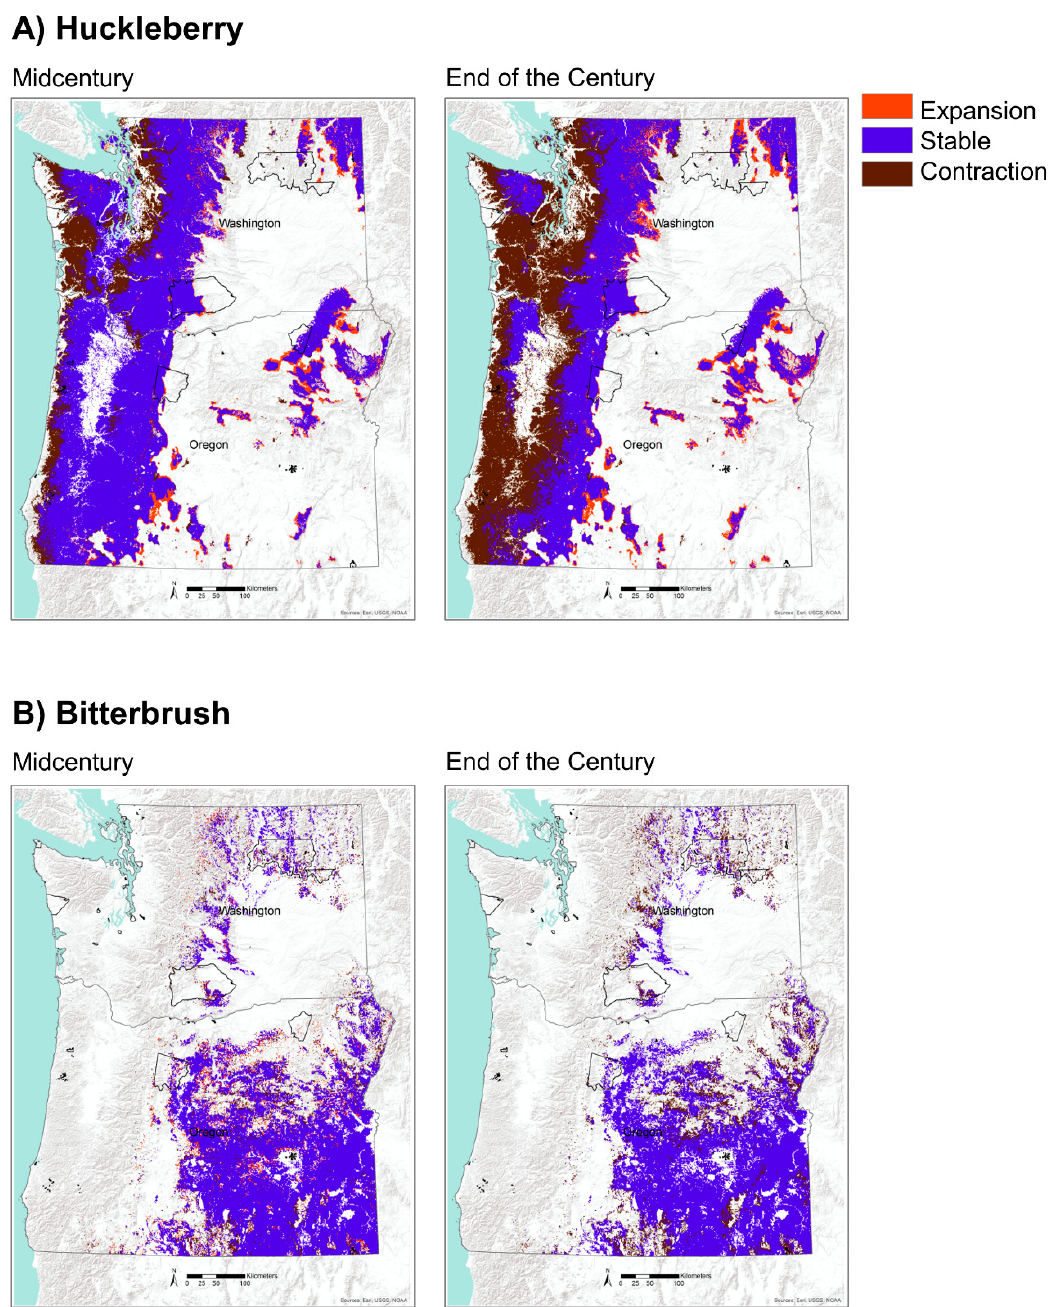
Figure 7. Projected potential habitat for ( A ) huckleberry (top row) and ( B ) bitterbrush (bottom row) based on the CESM1-CAM5 GCM for mid and end of the century under RCP 8.5. Tribal reservations are delineated with black polygons.